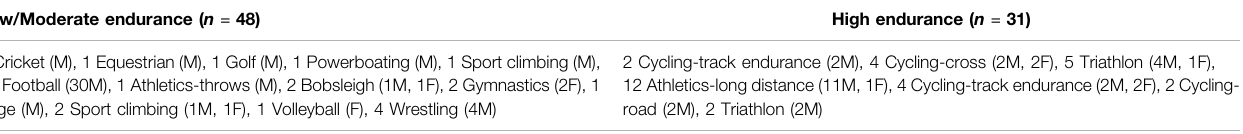
TABLE 1 | Classi fi cation of participants (males: M and females: F) according to the endurance intensity of their respective sports. Low/Moderate endurance ( n = 48) High endurance ( n = 31) 1 Cricket (M), 1 Equestrian (M), 1 Golf (M), 1 Powerboating (M), 1 Sport climbing (M), 30 Football (30M), 1 Athletics-throws (M), 2 Bobsleigh (1M, 1F), 2 Gymnastics (2F), 1